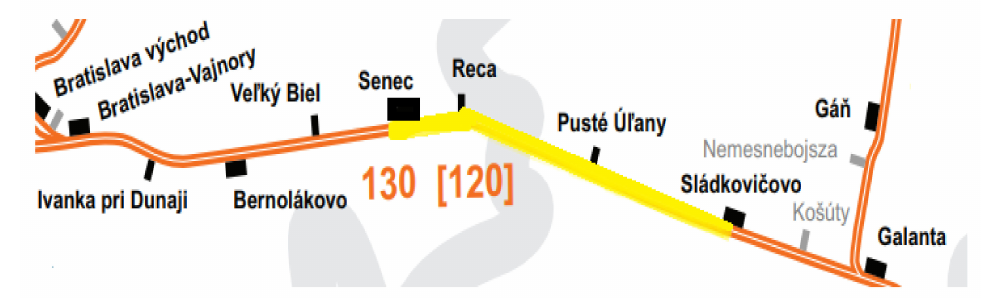
Figure 6. Marked chosen railway section.